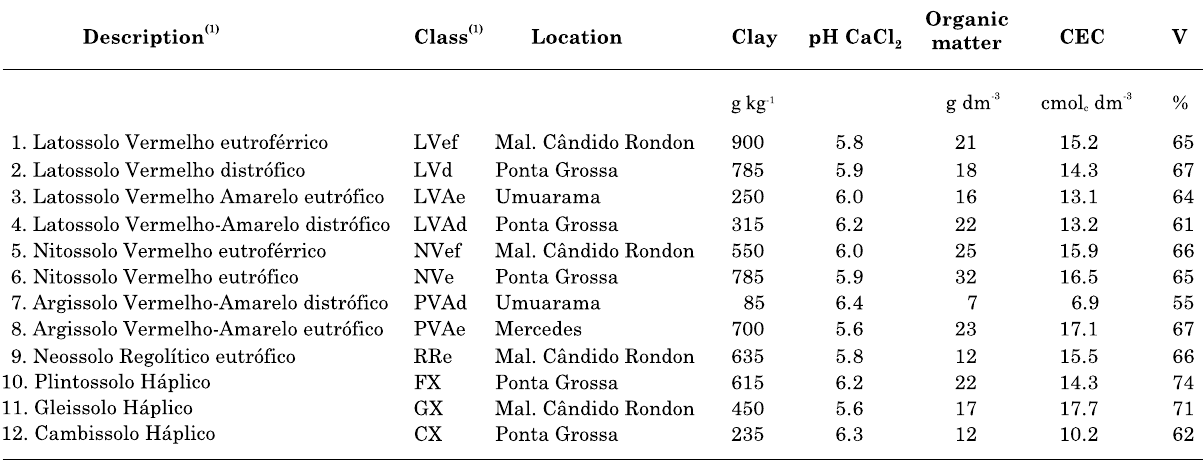
(1) Brazilian Classification as proposed by Embrapa